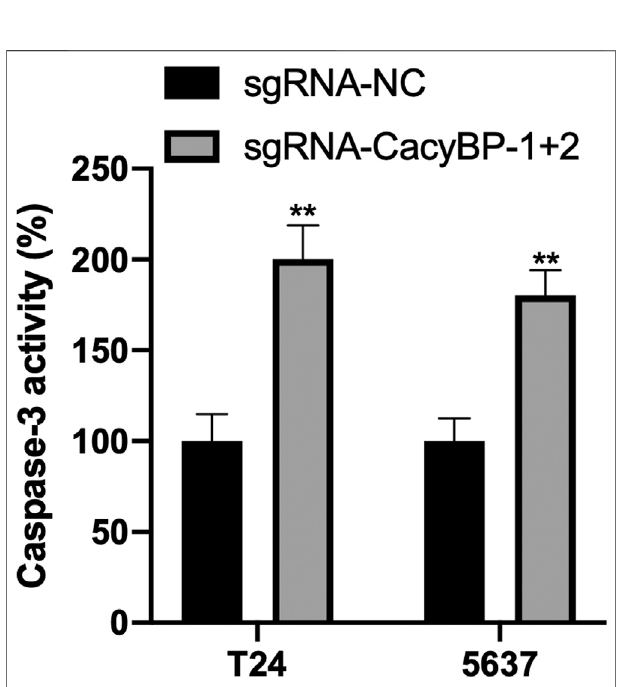
FIGURE 5 | Downregulation of CacyBP promoted the apoptosis of bladder cancer cells detected by caspase3-Elisa. ** p < 0.01.